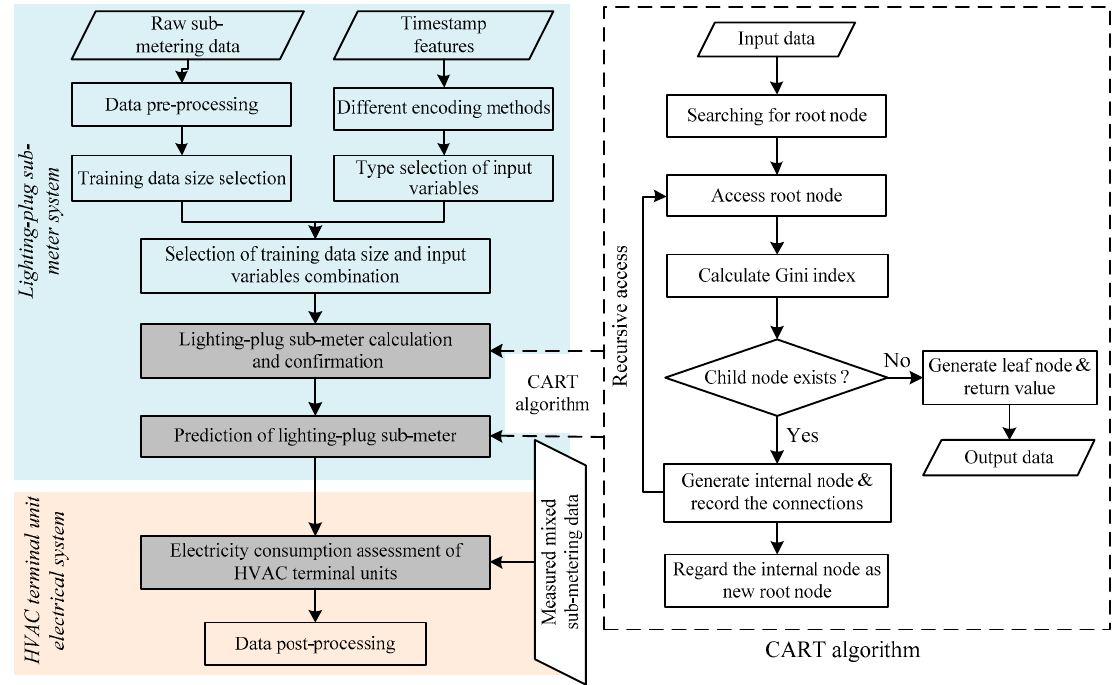
Figure 3. The establishment procedure of a CART model.